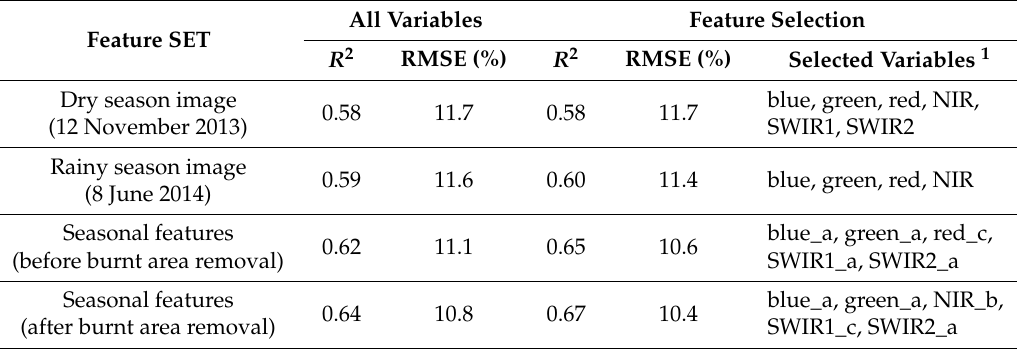
Table 4. Accuracy of tree crown cover predictions.